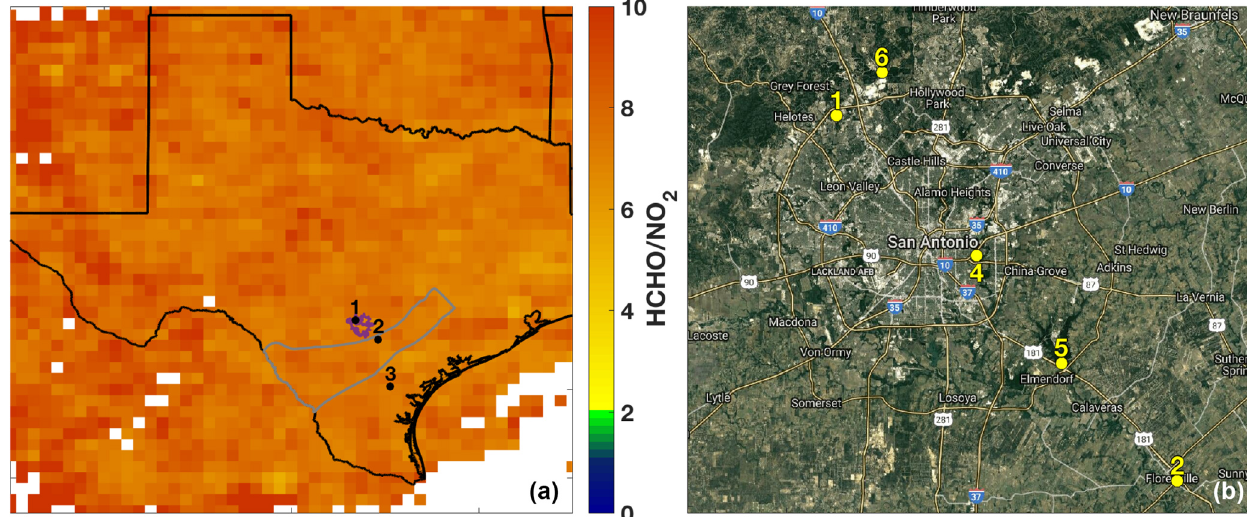
Figure 2. (a) The sampling locations for the AML are indicated: 1 – University of Texas San Antonio, 2 – Floresville, and 3 – Lake Corpus Christi. The ratio of total column HCHO to tropospheric column NO 2 averaged over the months of May through July 2017 is also shown for grid boxes with 10 or more observations of both species over the indicated time period. The outlines of the Eagle Ford Shale (grey) play and San Antonio city limits (purple) are also shown for reference. (b) The major roadways and TCEQ monitoring stations (6: Camp Bullis, 4: Pecan Valley, 5: Calaveras Lake) in the San Antonio region used in this study are shown. The UTSA and Floresville SAFS sites are also shown for